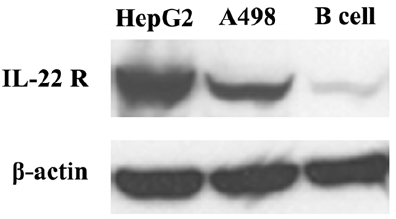
Figure 4. Expression of IL-22R on the surface of cells by western blot assay. Western blot assay was performed to detect the expression of IL-22R on the surface of cells using mouse IL-22 R a 1 antibody. The results showed a measurable expression of IL-22R on the surface of A498 cells compared with that of HepG2 cells and human B cells, which served as positive control and negative control respectively. N=3.